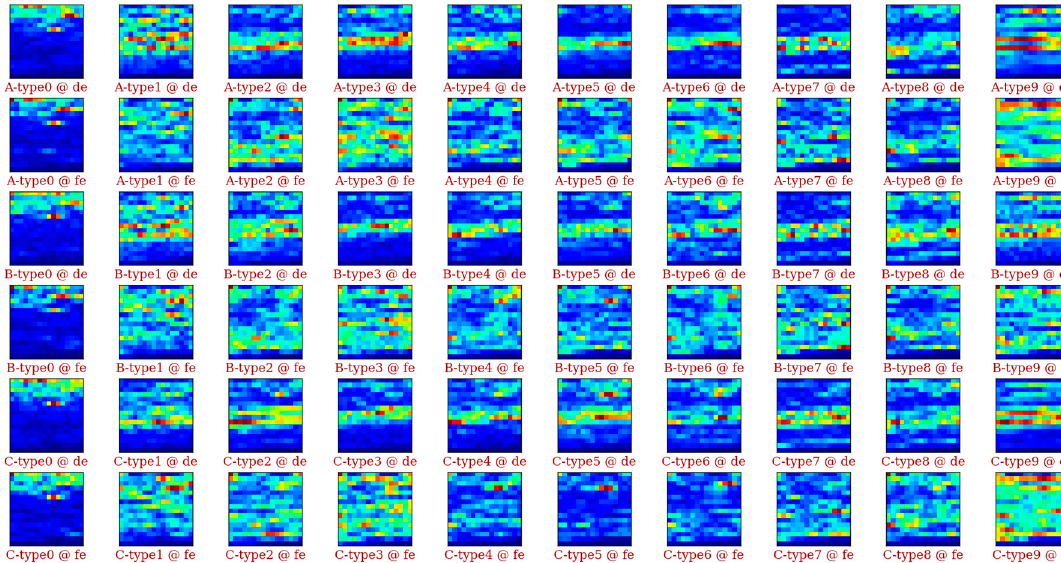
Figure 5. Data visualization of the input data 16 × 16 RMS maps.